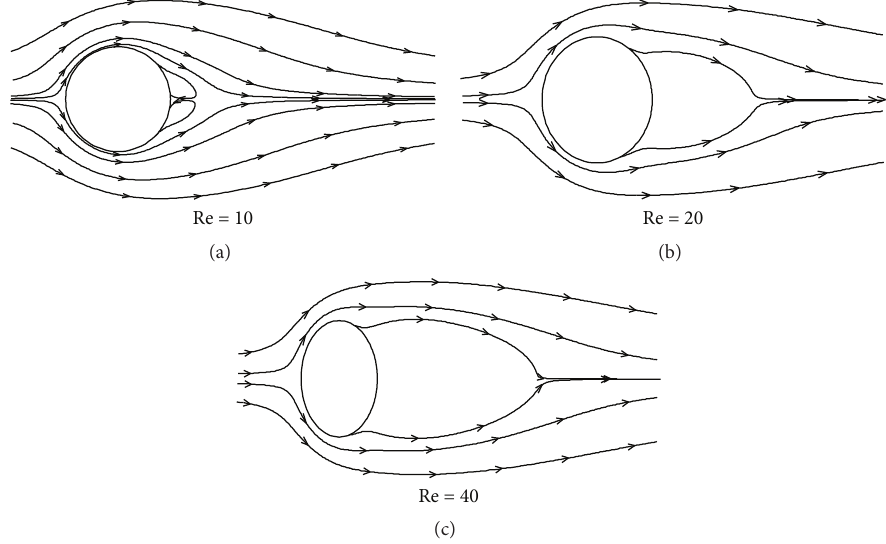
Figure 6: Streamline contour for Re = 10, 20, and